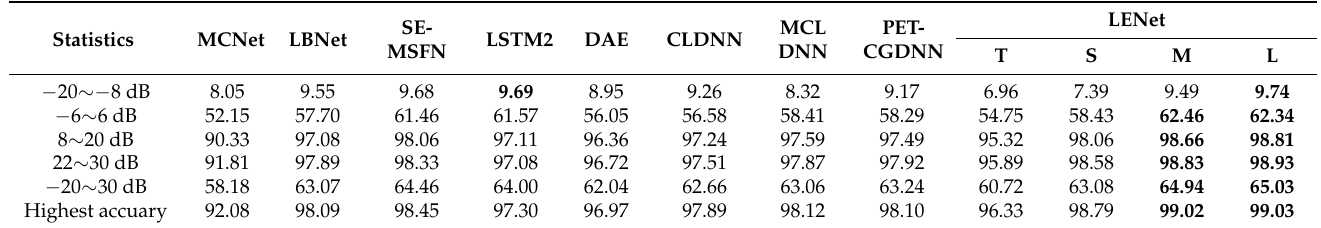
Table 5. Results of statistical analysis of all models’ classification accuracy on the 2018A dataset. The top2 for each statistic are